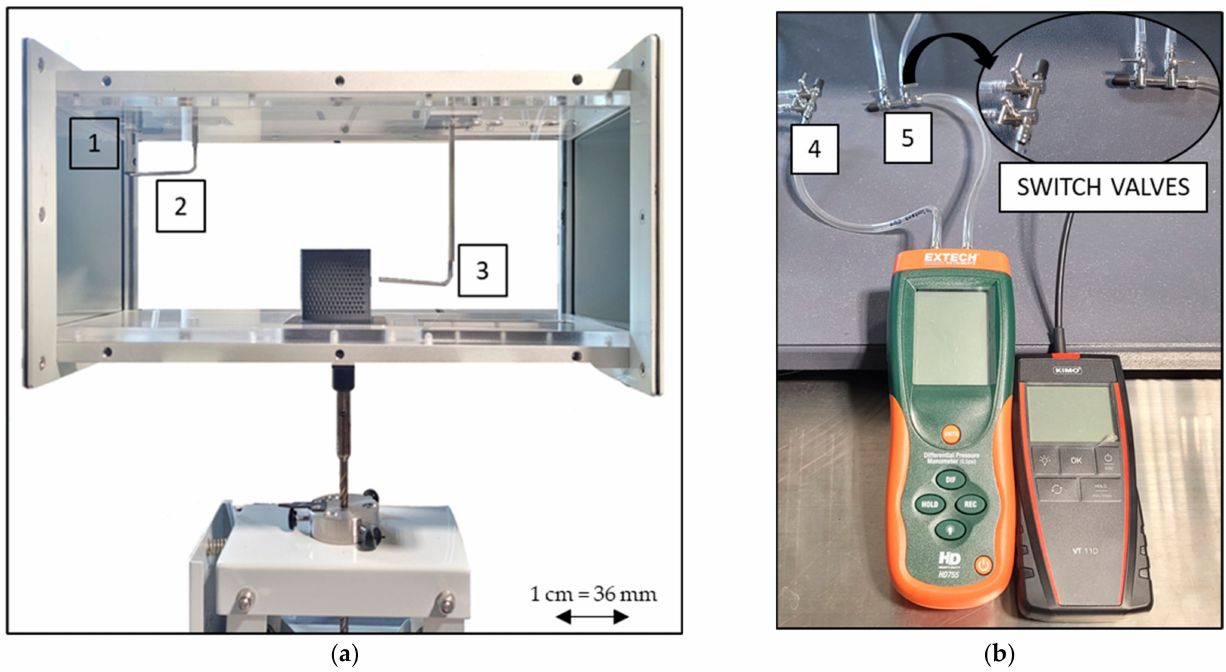
Figure 3. ( a ) Subsonic wind tunnel working section with the fin; ( b ) digital manometer and hot wire anemometer together with the switch valve assembly.